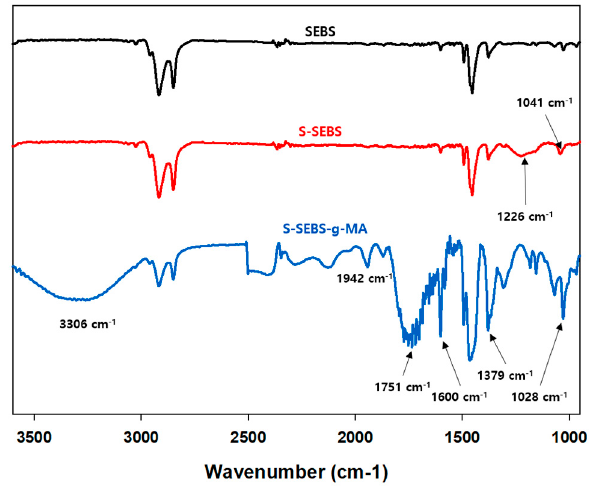
Figure 3. The FT-IR spectra of the SBES, S-SEBS, and S-SEBS-g-MA membranes. However, after grafting by MA, S-SEBS-g-MA has a new peak a at 3306 cm − 1 because of the hydroxyl group together with some unassociated hydroxyl species in the region 3500–3200 cm − 1 . There are also several other new peaks at 1942 and 1751 cm − 1 (asymmetric and symmetric carbonyl vibration of MA), 1600 cm − 1 (C=O stretching of carboxyl group from anhydride), 1379 cm − 1 (aldehyde), 1028 cm − 1 (the deformation vibration of the C-H bond) [23,24]. The FT-IR results suggest that the functional groups are responsible for ionic transfer channel of hydroxide ions are successfully grafted on SEBS.